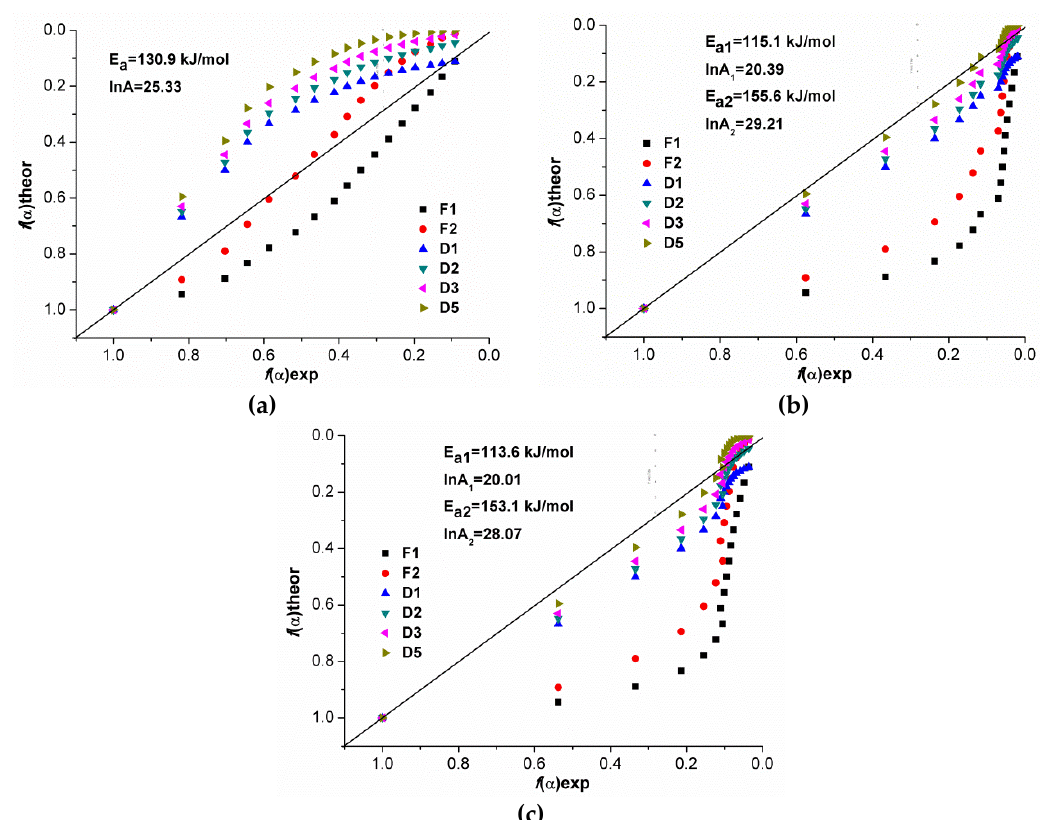
Figure 11. Comparison of experimental and theoretical f ( α ) for depolymerization in the presence of ZnO ( a ), γ -Al 2 O 3 ( b ), and without catalyst ( c ) at 5 K/min.